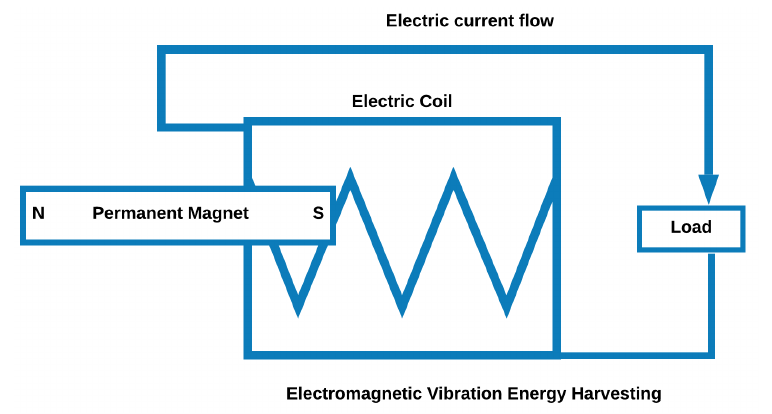
Figure 3. Electromagnetic Vibration Energy